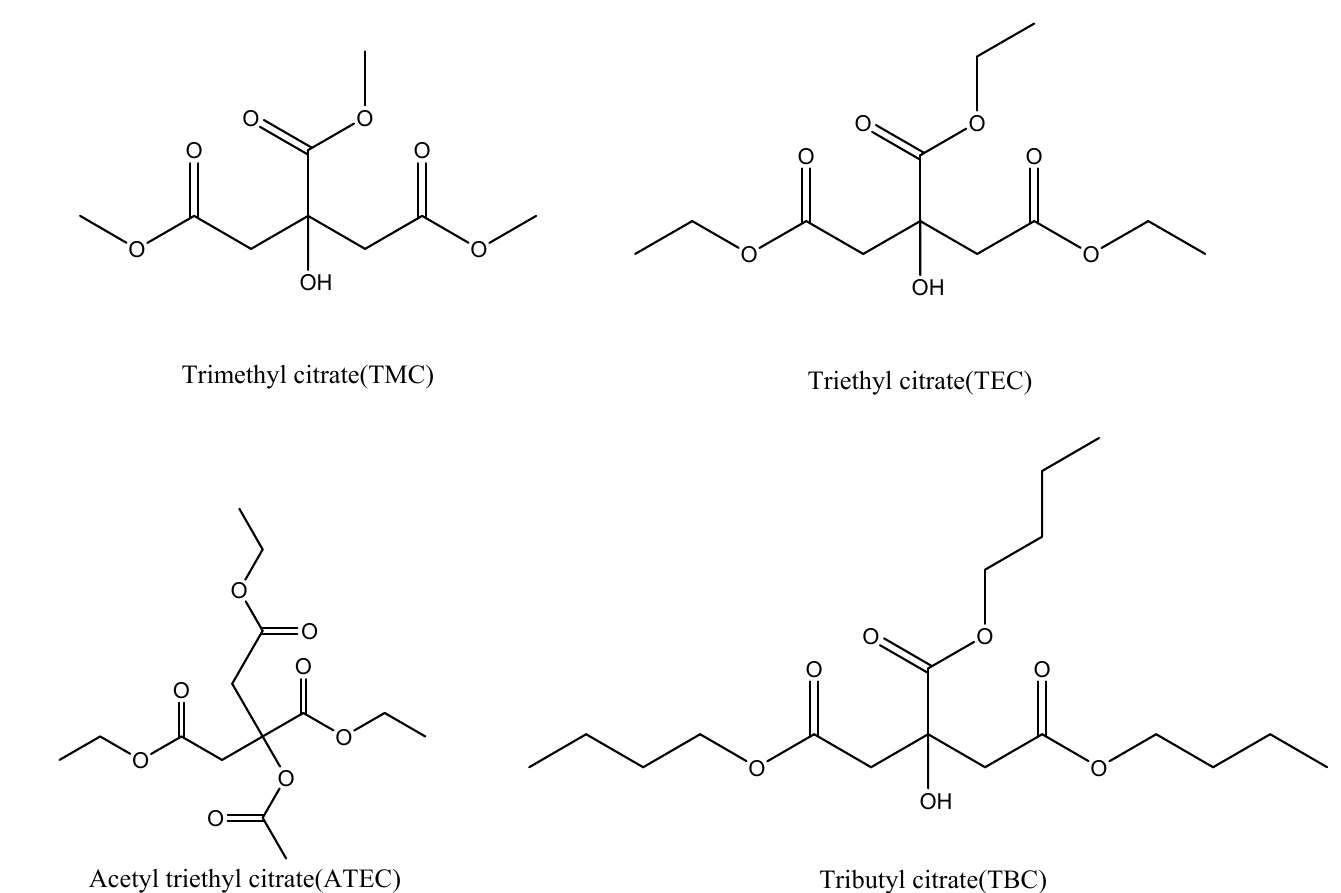
Scheme 1. Structures of trimethyl citrate (TMC), triethyl citrate (TEC), acetyl triethyl citrate (ATEC), and tributyl citrate (TBC).